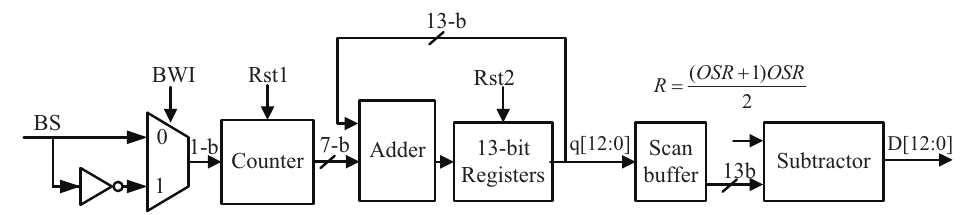
Figure 9. Block diagram of a second digital decimation filter.